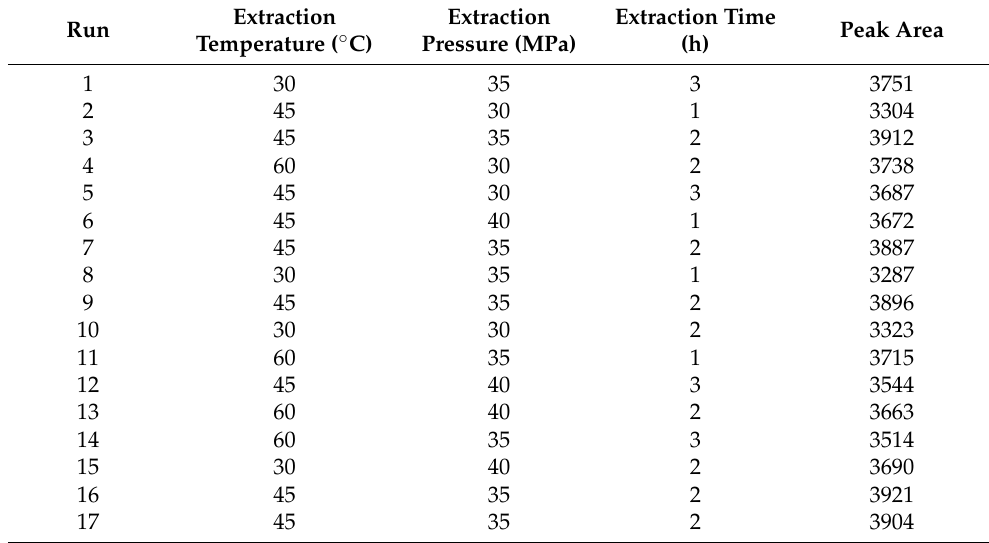
Table 2. The experimental design and data for SFE, obtained via BBD for fatty acids ( n = 3).